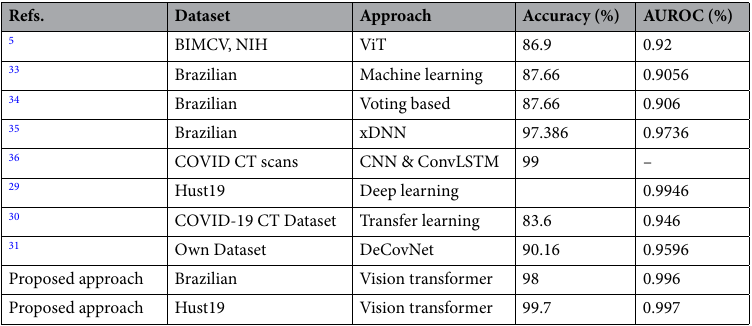
Table 2. Accuracy of classifiers on binary and multi-class